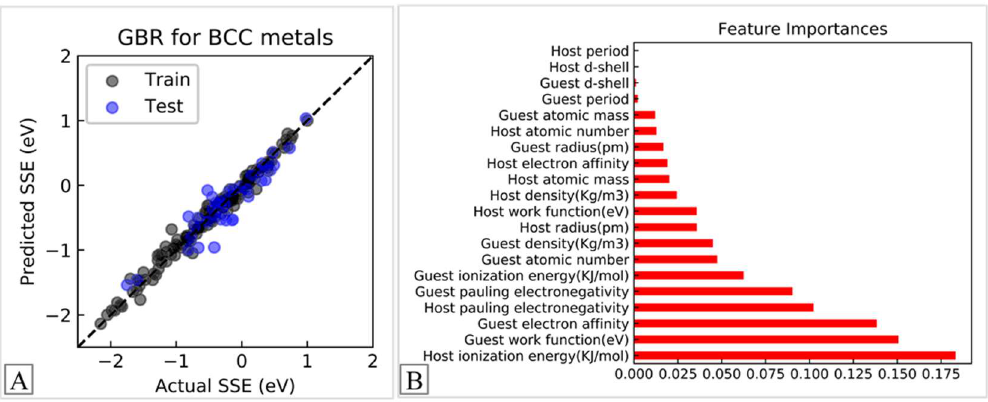
Figure 4. ( A ) Model predictions and ( B ) Feature importance scores for BCC(110) surfaces obtained from the GBR model. SSE = surface segregation energy.